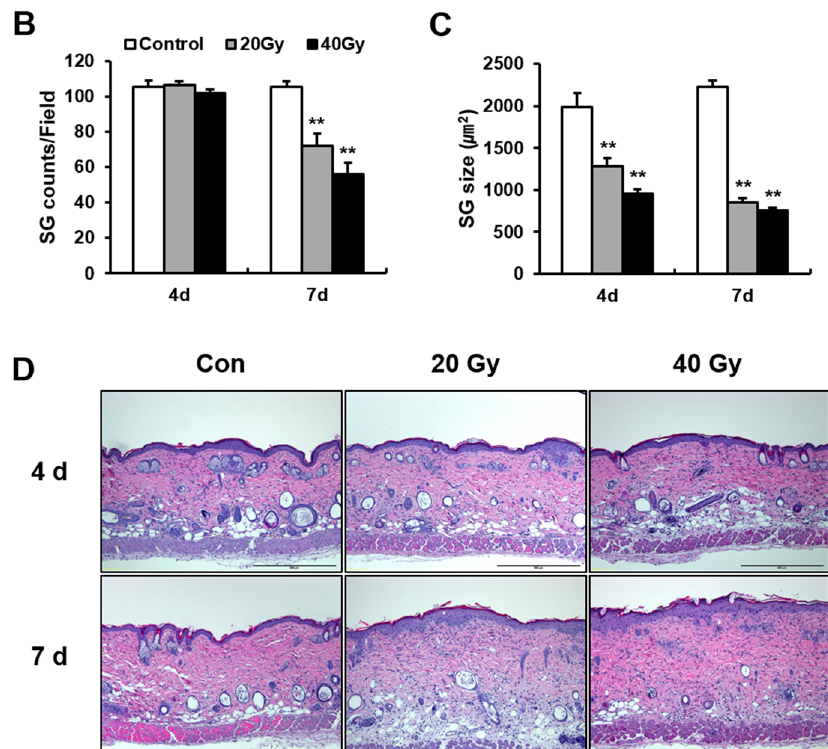
Figure 4. Decrease of sebaceous gland size and number by irradiation in the latent stage. ( A ) Optical microscopy view of sebaceous glands (SGs) in the epidermal sheet of 0 (Control; Con), 20, and 40 Gy irradiated skin at 4 and 7 days. Scale bar = 200 μ m. Analysis of ( B ) the number of SGs and ( C ) the size of SGs in the irradiated skin of 0 (Control), 20, and 40 Gy groups at 4 and 7 days. ( D ) H&E stain of the 0 (Control; Con), 20, and 40 Gy irradiated skin at 4 and 7 days. Scale bar = 500 μ m. Data are presented as the mean ± standard error of the mean. n = 5 mice for each group. ** p < 0.01 compared with the control.